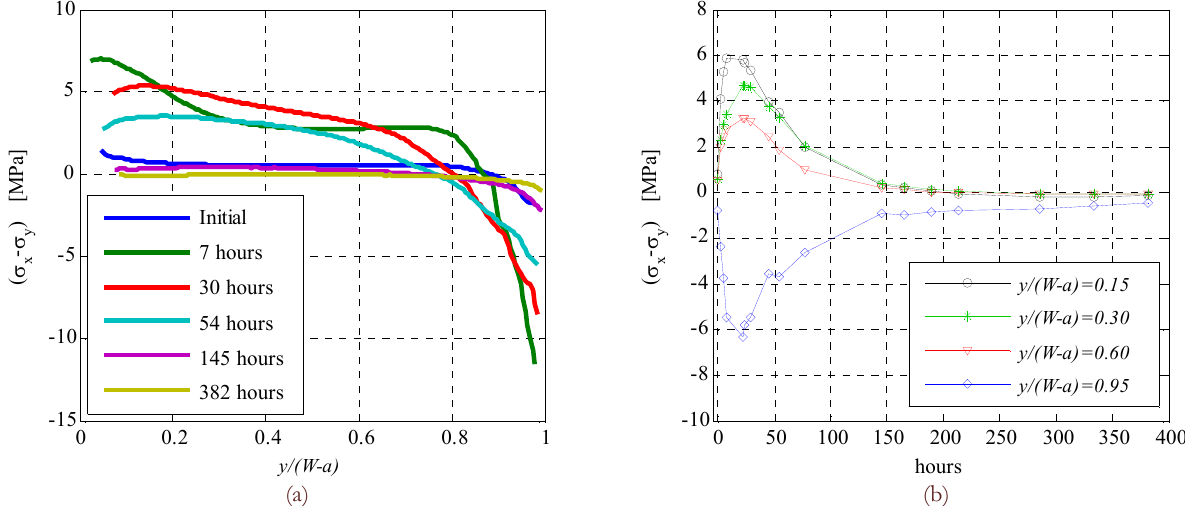
Figure 5: (a) Plots of (  x -  y ) along the ligament of material ahead of the crack, for various aging times; (b) plots of (  x -  y ) versus time on selected points of the same